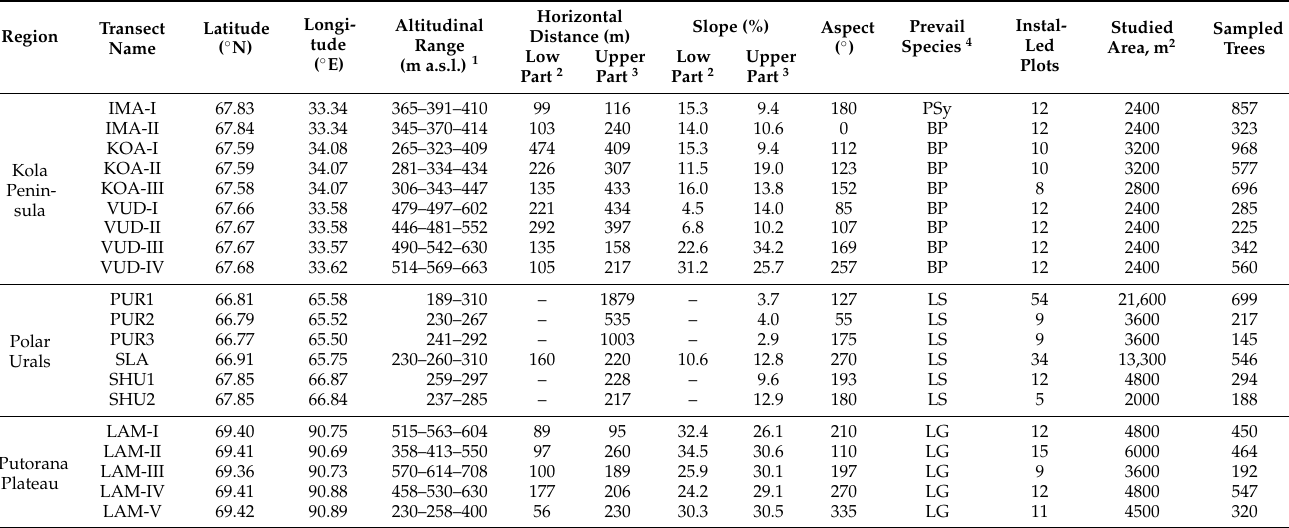
Table 2. General description of studied altitudinal